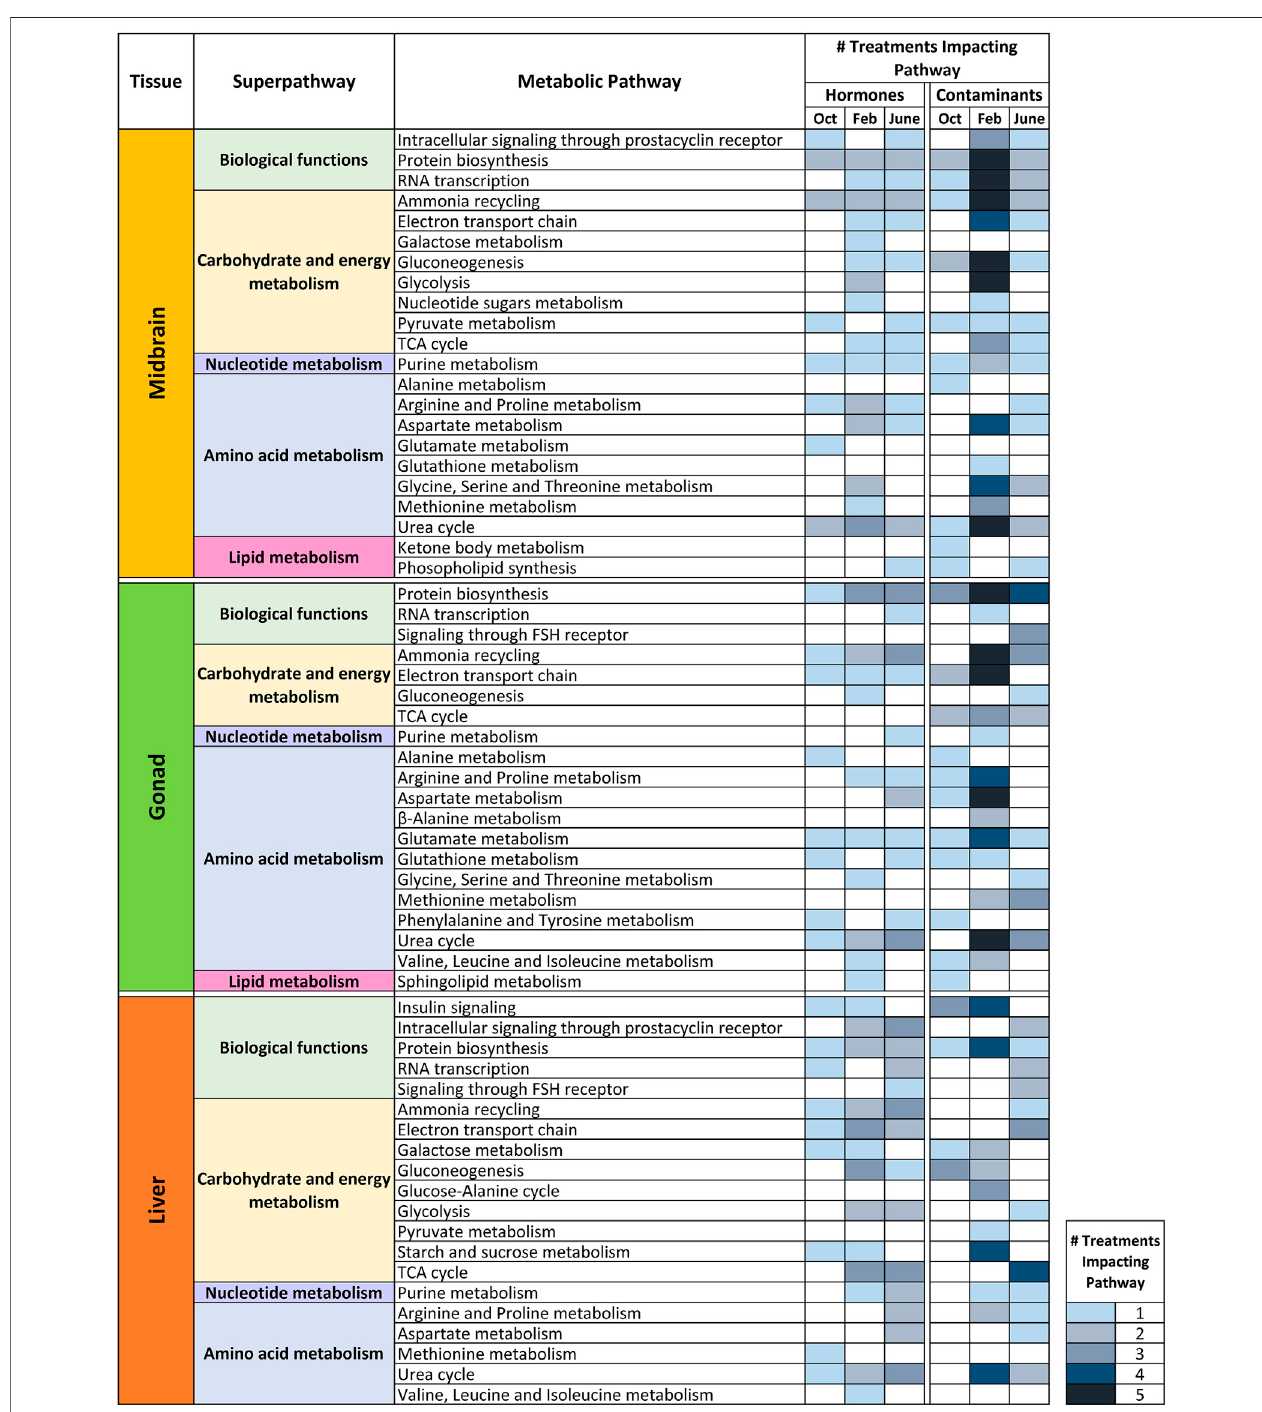
FIGURE 6 | Impact of hormone or contaminant treatments on biochemical pathways in midbrain, gonad and liver in October, February and June. Heatmap depicting a summary-level view of speci fi c biochemical pathways altered by hormone or contaminant exposures across tissues and seasons analyzed. Biochemical pathwaysarecategorizedbyKEGGsuperpathways.Thegraded-colorheatmapdepictsthenumberoftreatmentsfoundtoimpactabiochemicalpathwayinaparticular tissue and season. Results are based on the Metabolite Set Enrichment Analysis (MSEA).